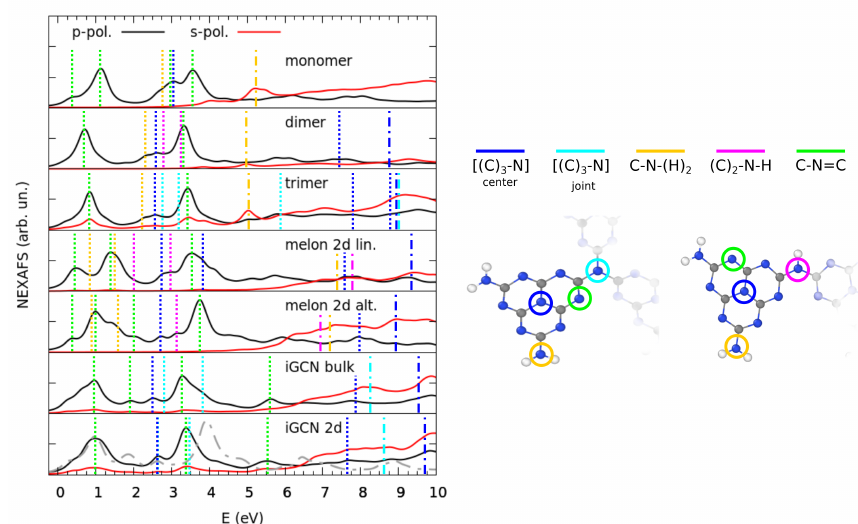
Figure 6. Comparison of NEXAFS spectra calculated for different models of gCN and melem aggregates for both X-rays polarizations. Excitation energies were shifted aligning the position of the onset of the absorption. For 2D igCN, the gray dot-dash line shows the spectrum of the flat model with p polarization. The position of the contributions from inequivalent N atoms for the p or s polarization is marked on the spectra through the vertical dashed or dot-dashed lines,